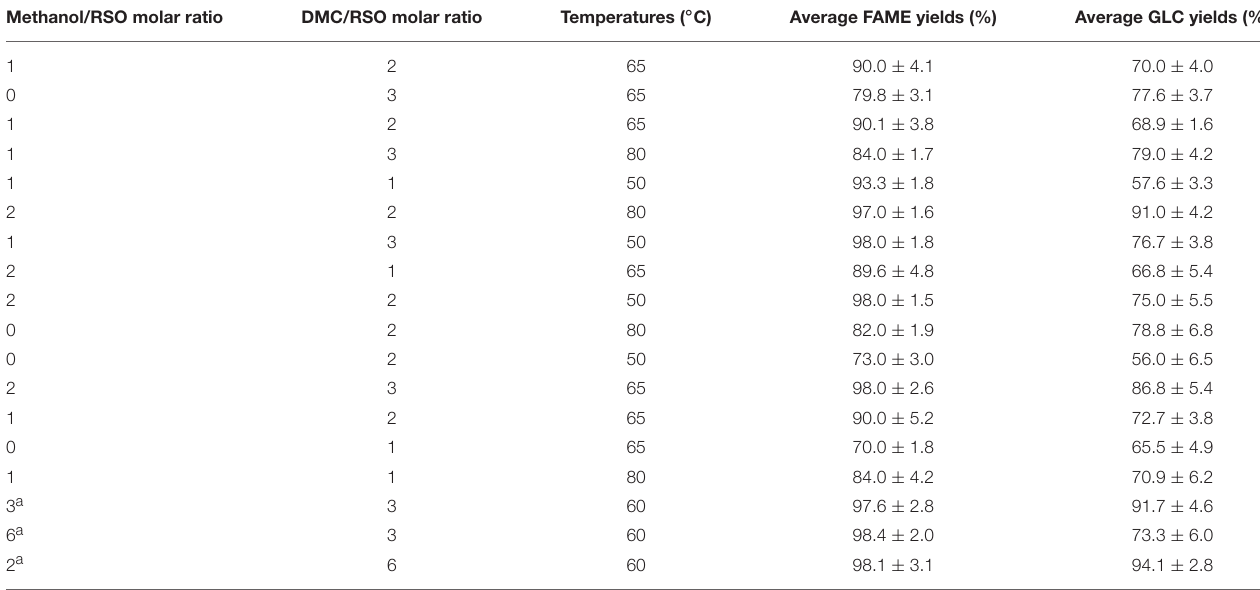
TABLE 2 | FAME and GLC yields from duplicate experiments at various reaction conditions for the design of experiment. Methanol/RSO molar ratio DMC/RSO molar ratio Temperatures ( ◦ C) Average FAME yields